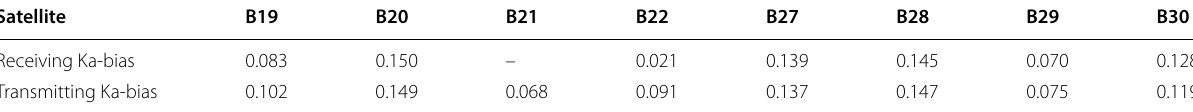
Table 3 Repeatability of the estimated Ka‑biases for each satellite obtained in EXP2 (unit: m)